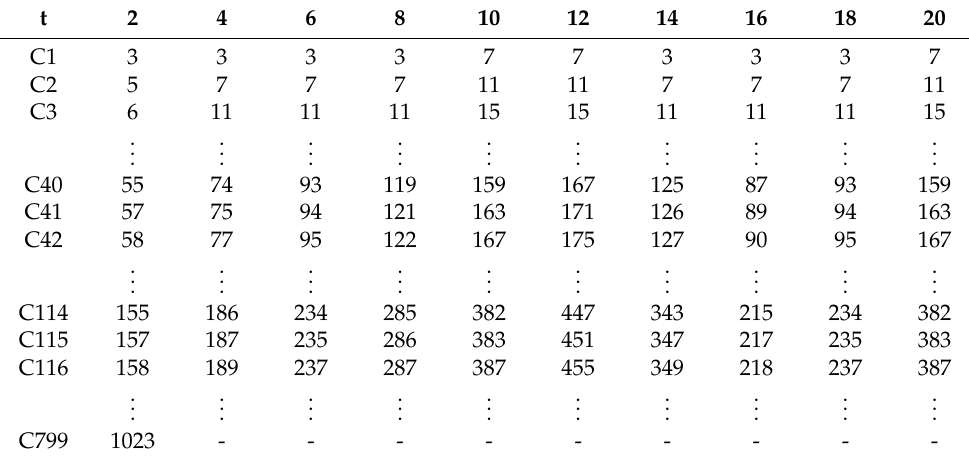
Table 4. Convex object obtained from Boolean encoding.